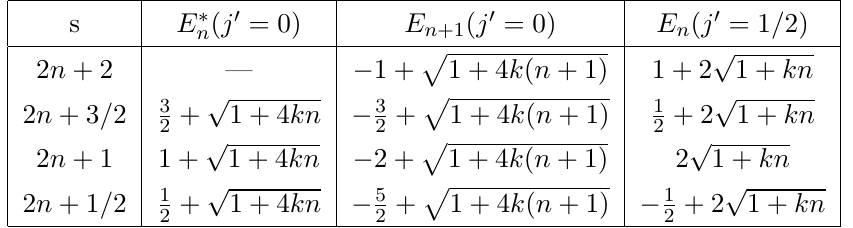
Table 3 . Candidates for subleading Regge trajectory with 2 n < s (cid:20) 2 n + 2.